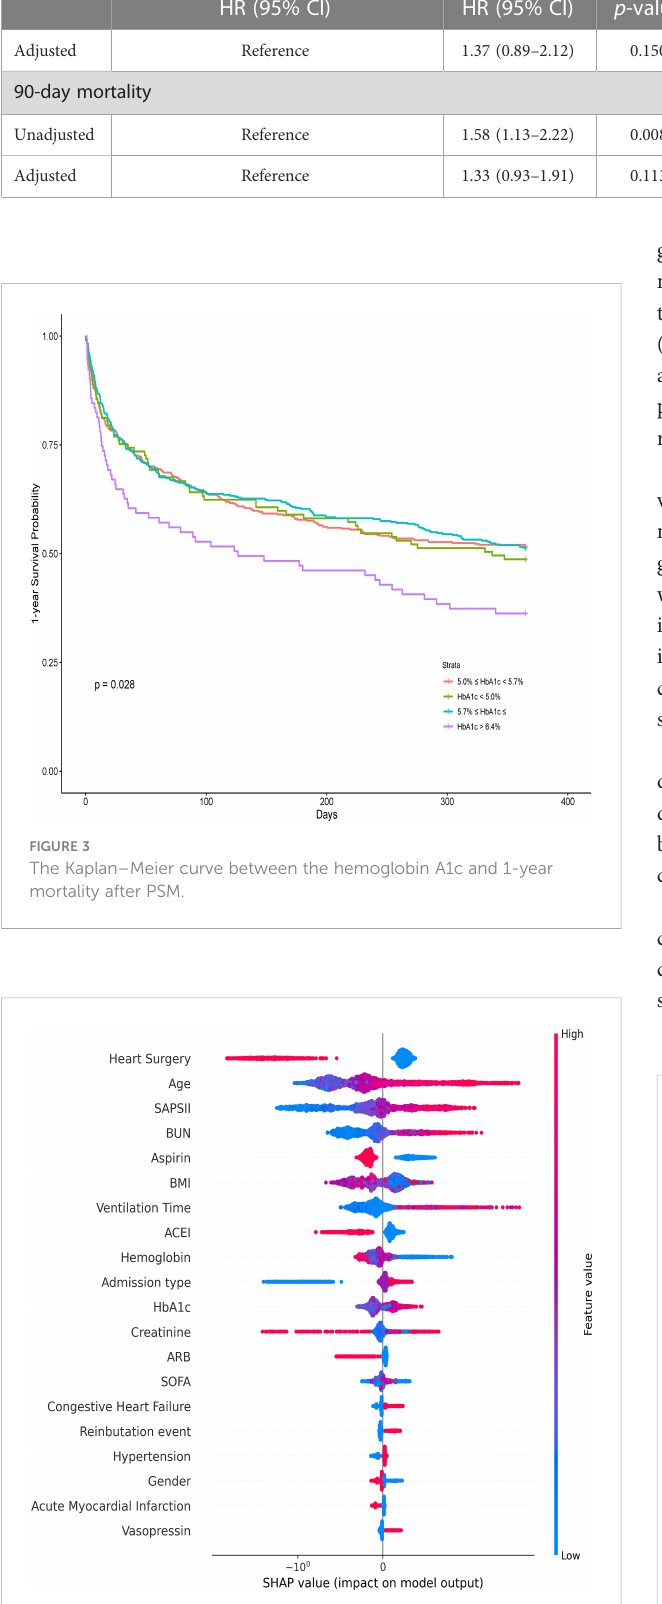
FIGURE 5 The ROC of the training dataset and the testing dataset in the XGBoost machine learning